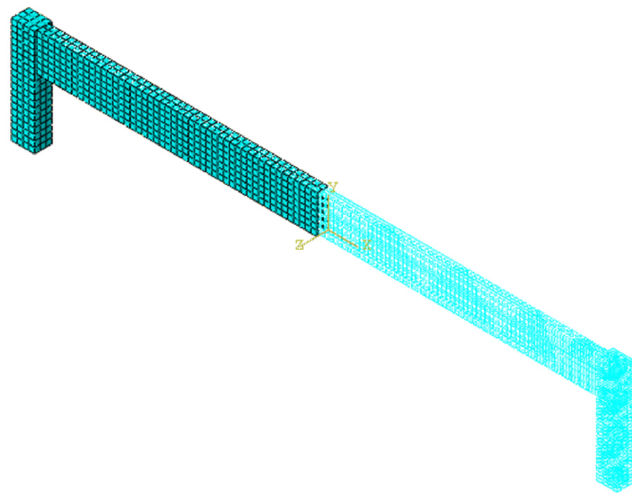
Table 2. Material parameter values for the finite element model.